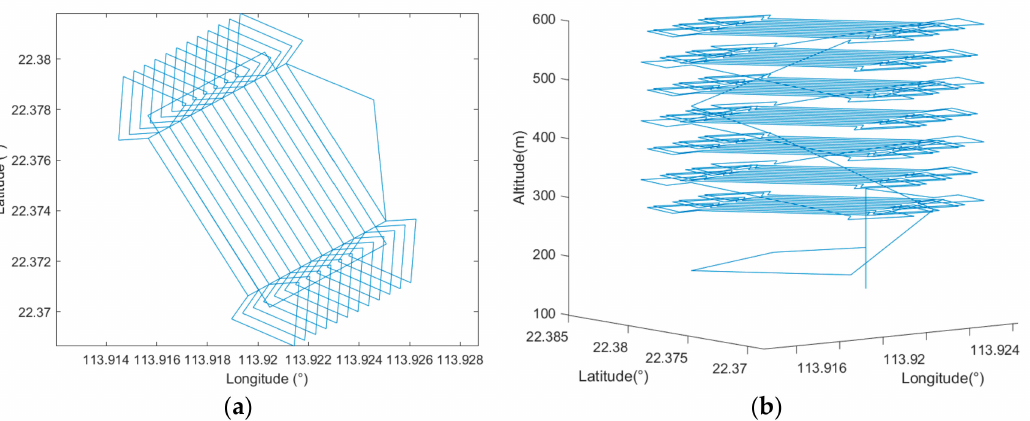
Figure 16. ( a ) Bird’s eye view of the cycle-Boustrophedon waypoints and ( b ) the 3D